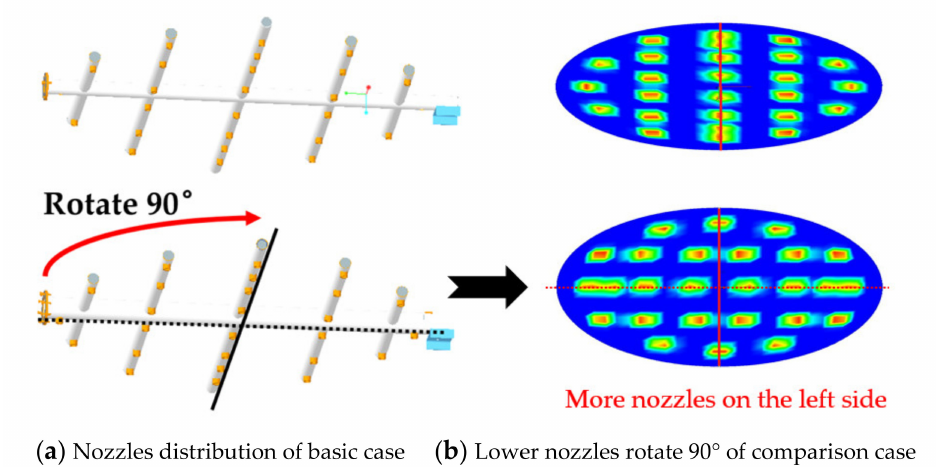
Figure 13. Distribution of the spray nozzles.